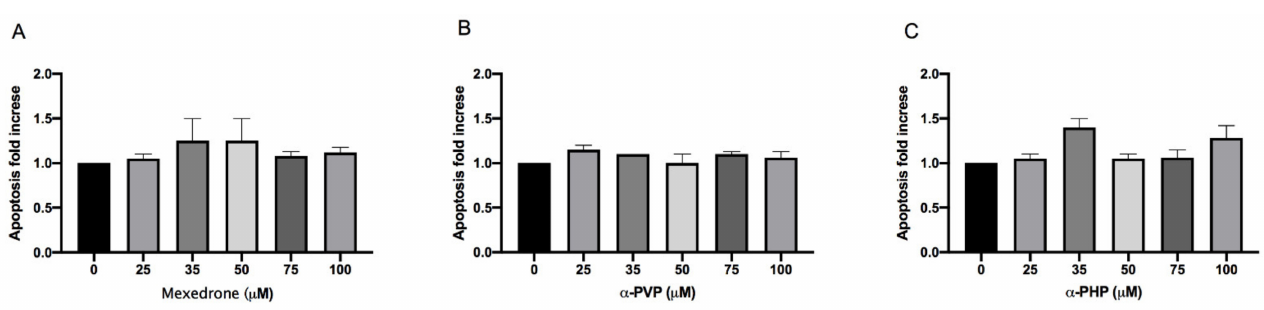
Figure 2. Apoptosis fold increase on TK6 cells after 26 h treatment with mexedrone ( A ), α -PVP ( B ) and α -PHP ( C ) at the indicated concentrations compared to the negative control [0 µ M]. Each bar represents the mean ± SEM of five independent experiments. Data were analyzed using repeated ANOVA followed by Dunnet post-tests.